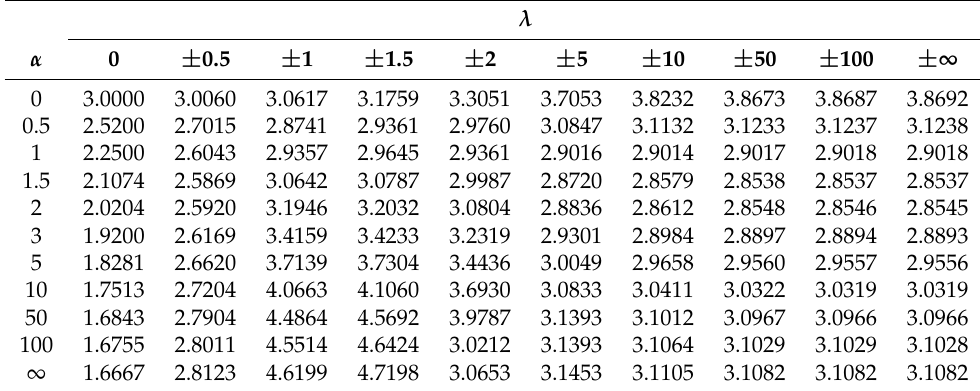
Table 3. Possible values of the standardized kurtosis